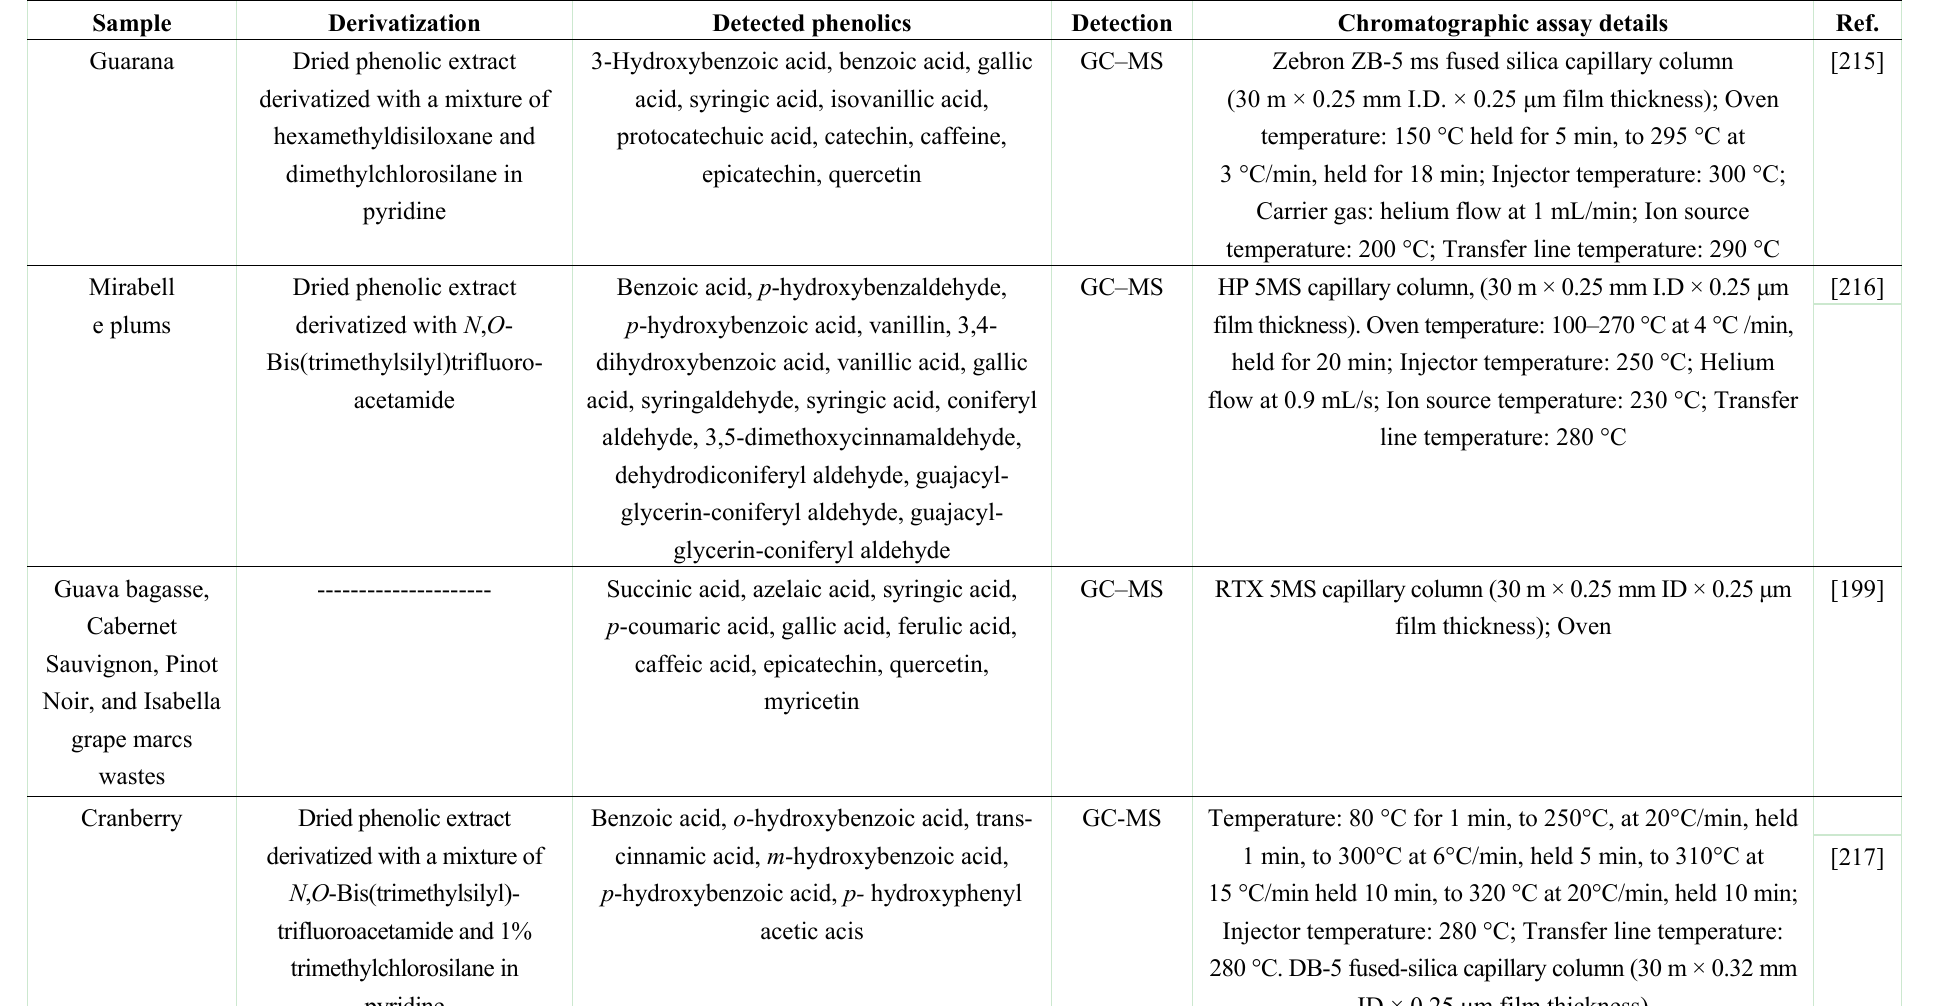
Table 8. Summary of GC conditions to detect molecules belonging to phenolic